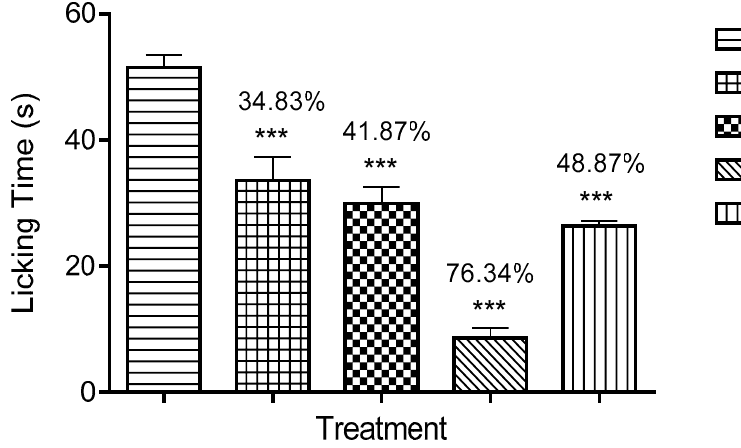
Figure 6. Effect of MEDL on bradykinin-induced nociception in mice. Each column represents the mean ± SEM of six mice. Statistical analyses were performed using 1-way ANOVA followed by Tukey’s multiple comparisons test. *** p ≤ 0.001 compared to vehicle control group. Values on top of each column denote inhibition.